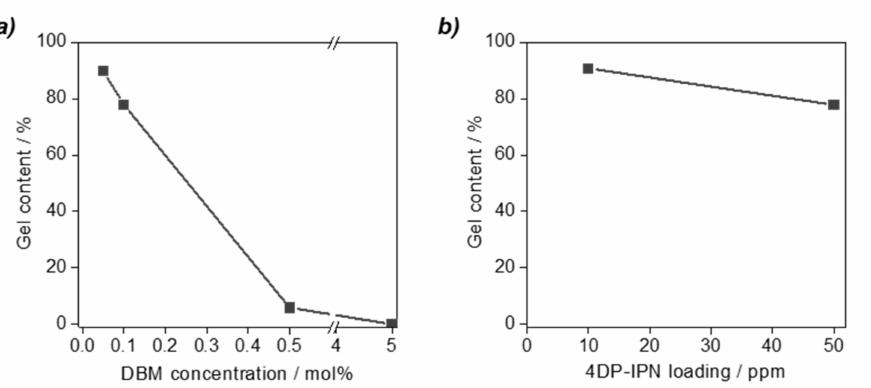
Figure 2. Gel content of the cured acrylic pressure-sensitive adhesives prepared using different: ( a ) diethyl 2-bromo-2-methylmalonate (DBM) concentrations (the 2,4,5,6-tetrakis(diphenylamino)- 1,3-benzenedicarbonitrile (4DP-IPN) loading and curing time were 50 ppm and 30 min, respectively) and ( b ) 4DP-IPN loadings (the DBM concentration and curing time were 0.1 mol% and 30 min,